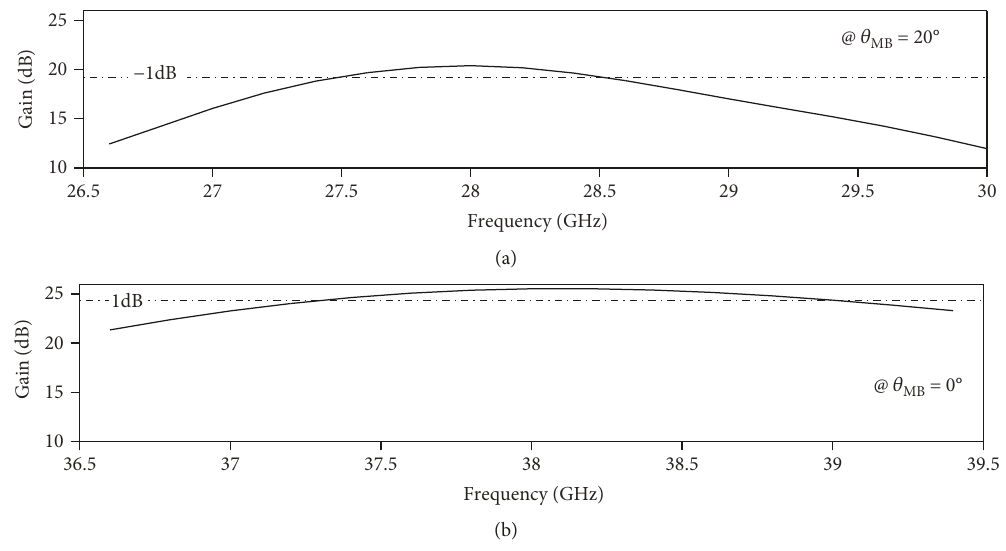
Figure 13: Simulated gain pattern versus frequency in the H -plane: (a) θ = 20 ° and (b) θ = 0 ° .